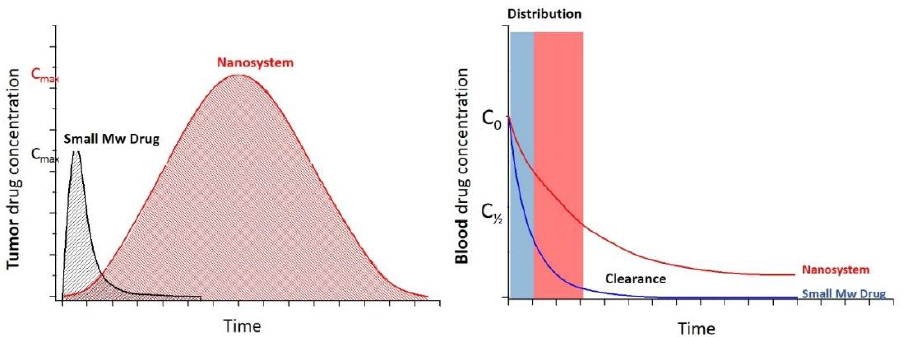
Figure 2. Typical pharmacokinetic profiles of small-molecule drugs and nanosystems in tumours (left) and blood (right).